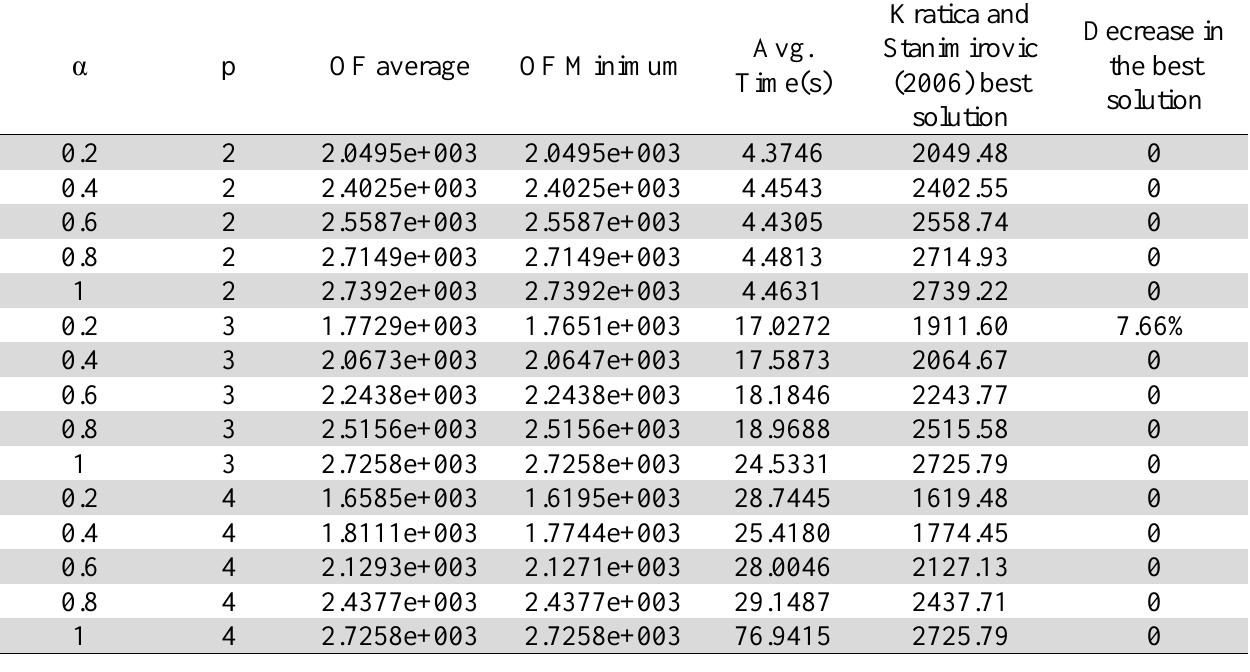
Results of the SA for different CAB data set instances